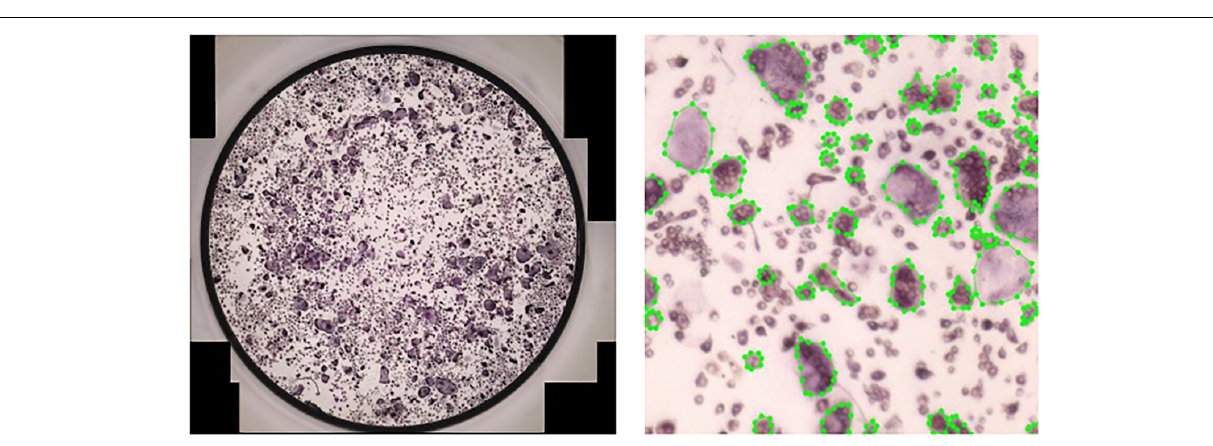
FIGURE 5 | Manual annotation of osteoclasts in cultures. Left: A full culture to be annotated. Right: A crop of size 1 16 × 1 16 of a fully annotated culture.